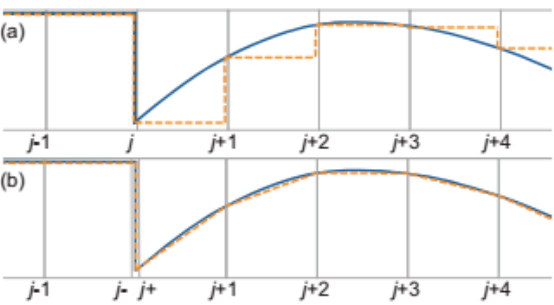
Figure 7. Energy-band diagram of a silicon p-n junction solar cell (Reproduced with perimission from [55], IEEE,